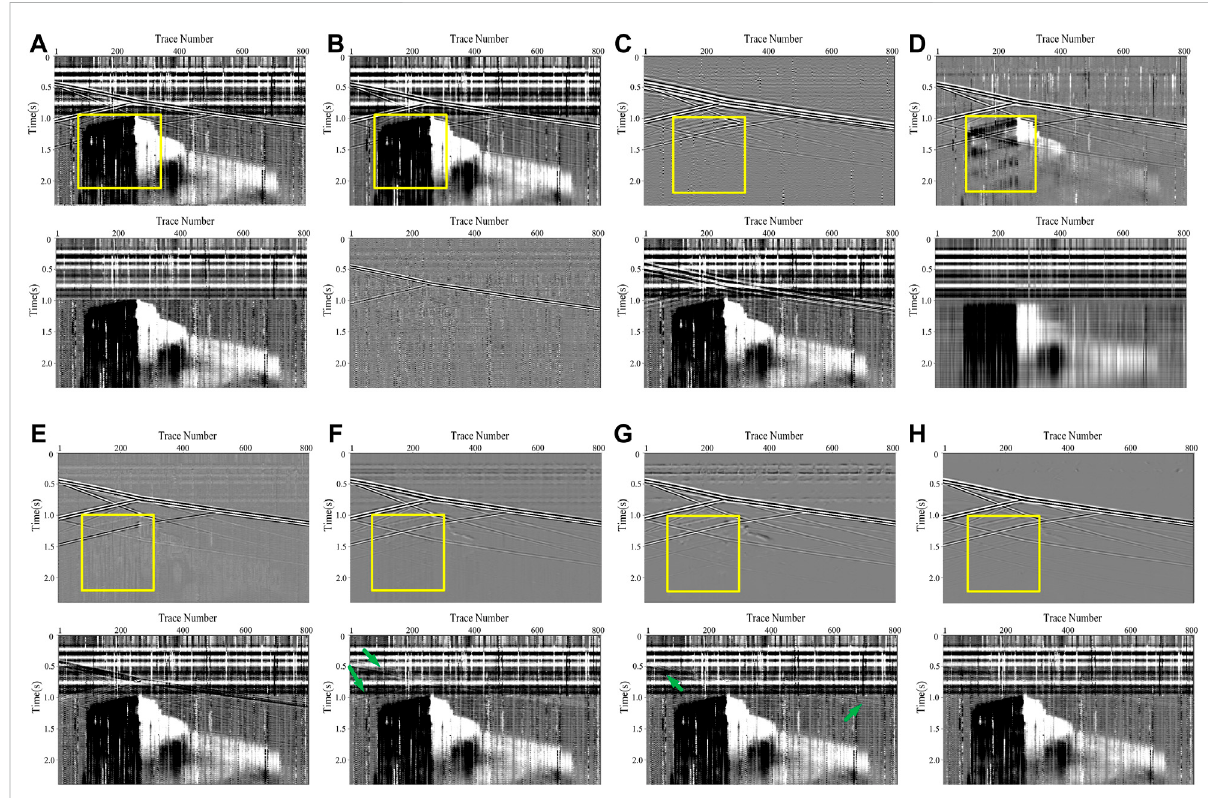
FIGURE 4 The processing results for different methods: (A) the clean data and the added DAS noise, and (B – H) represent the processing results of TFPF, BPF, RPCA, DnCNN, U-Net, RED-Net and MDD-Net,